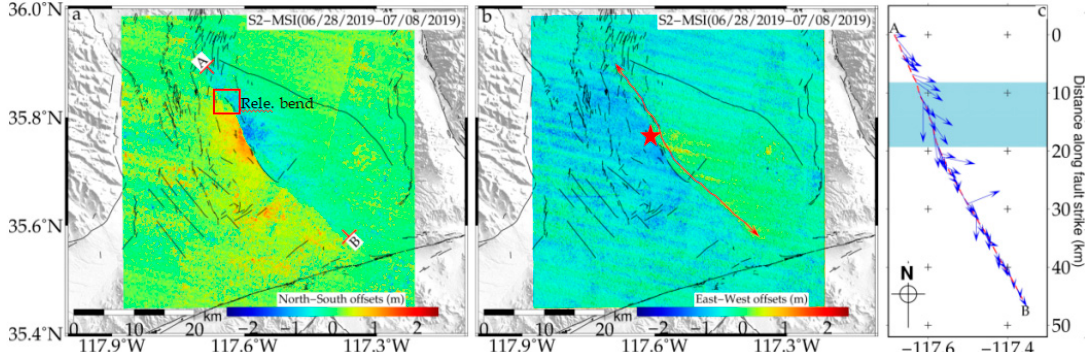
Figure 3. Horizontal displacement field of the 2019 Ridgecrest earthquake sequence. ( a ) North-south (NS) component of the horizontal displacement derived from Sentinel-2 optical images (28 June 2019–8 July 2019). The amplitude of the displacement is negative where the motion is southward and positive where the motion is northward; ( b ) East-west (EW) component of the displacement field derived from Sentinel-2 optical images (28 June 2019–8 July 2019). The amplitude of displacement is negative where the motion is westward and positive where the motion is eastward. The red star indicates the epicenter of the Mw7.1 event; ( c ) Displacement vectors (blue arrows) determined from the profile AB of the NS and EW horizontal displacements. Red dashed line indicates the surface rupture trace of the Mw7.1 event.